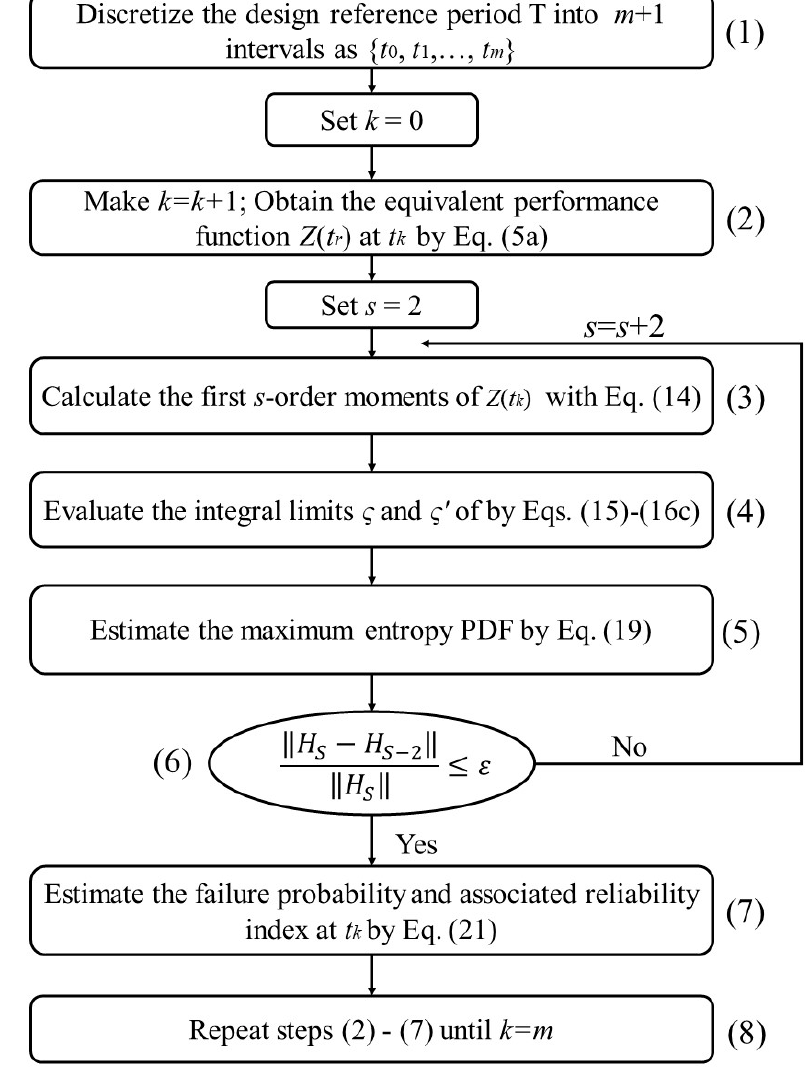
Figure 1. A flowchart to illustrate the implementation procedure of the proposed Figure 1. A fl owchart to illustrate the implementation procedure of the proposed method.